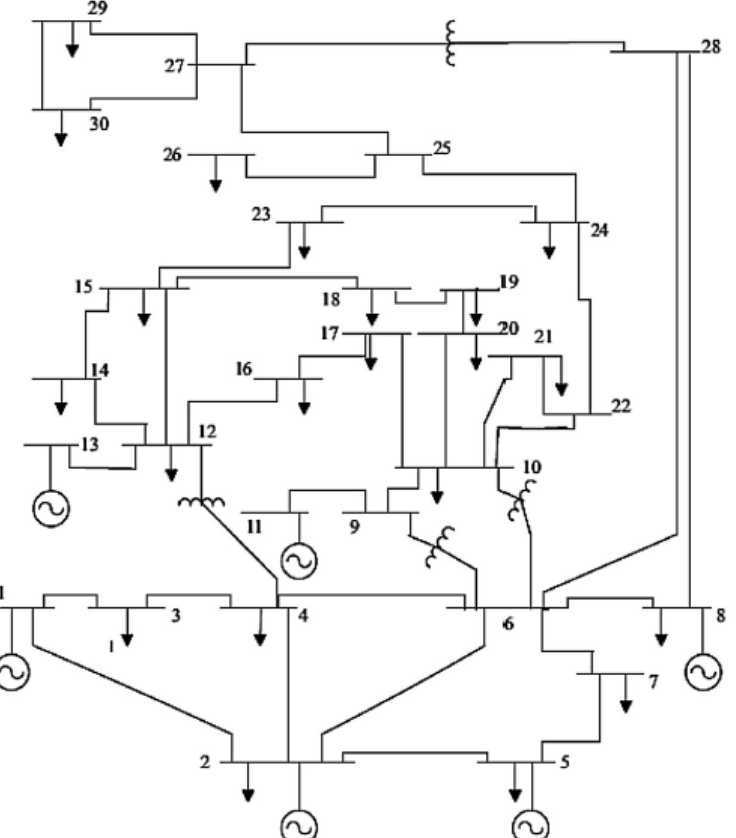
Figure 2. A schematic diagram of the IEEE 30 bus system, reproduced with permission from [22], Elsvier, 2017.